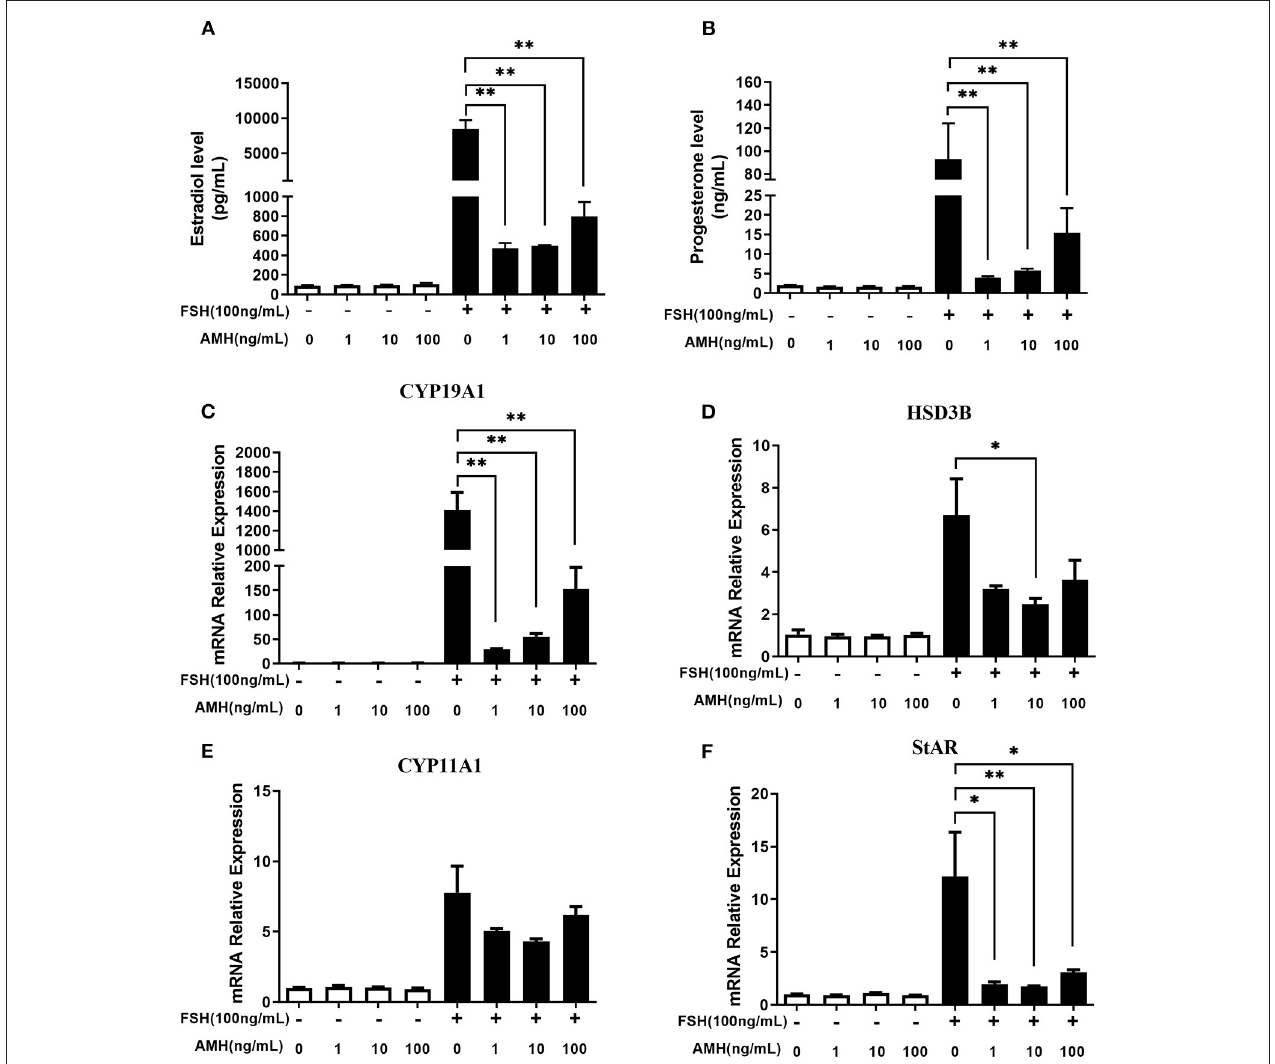
FIGURE 2 | Effects of anti-Müllerian hormone (AMH) on the biosynthesis and secretion of estradiol and progesterone by primary granulosa cells. (A,B) Estradiol and progesterone production in cells treated with increasing concentrations of AMH in the presence or absence of 100ng/ml FSH. (C–F) Relative expression of CYP19A1 , HSD3B , CYP11A1 , and StAR transcripts in cells treated with increasing concentrations of AMH in the presence or absence of 100ng/ml of FSH. Data are presented in mean ± SEM. * p < 0.05 and ** p < 0.01 between the indicated groups.